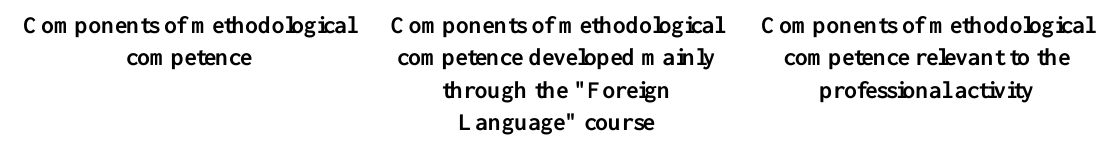
Table 2. Relationship among the survey results (replies to questions 10 and 11 statistically processed using the Excel program and subjected to expert interpretation)